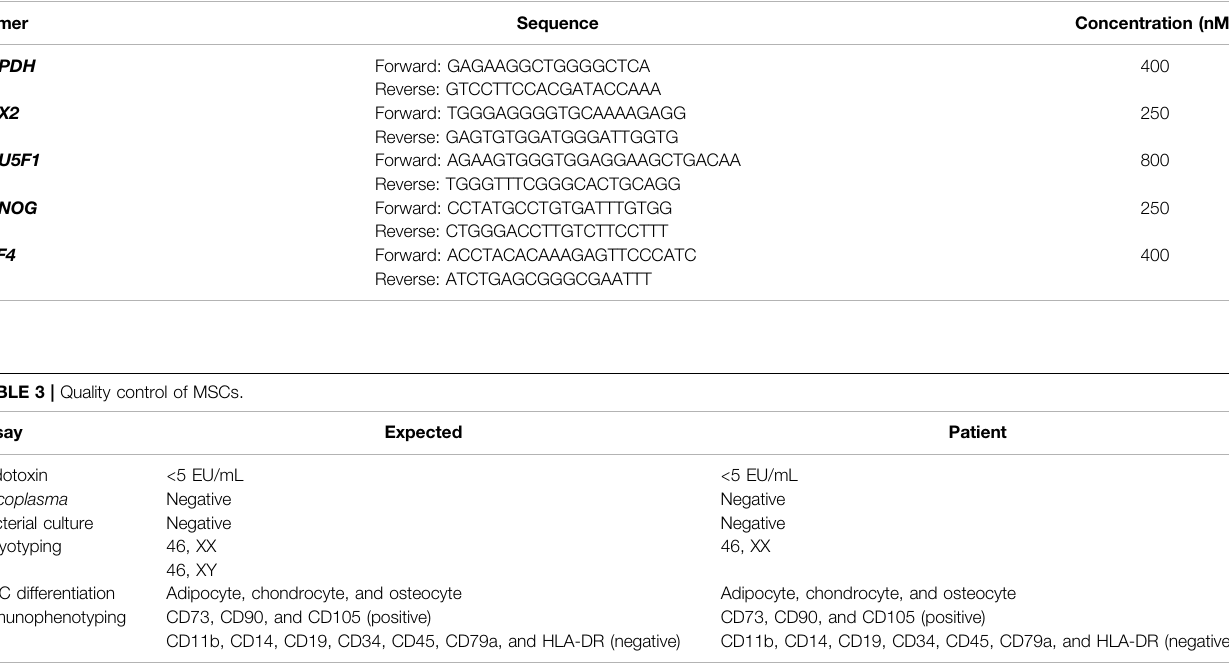
TABLE 2 | Sequence of gene-speci fi c primers used for qRT-PCR.